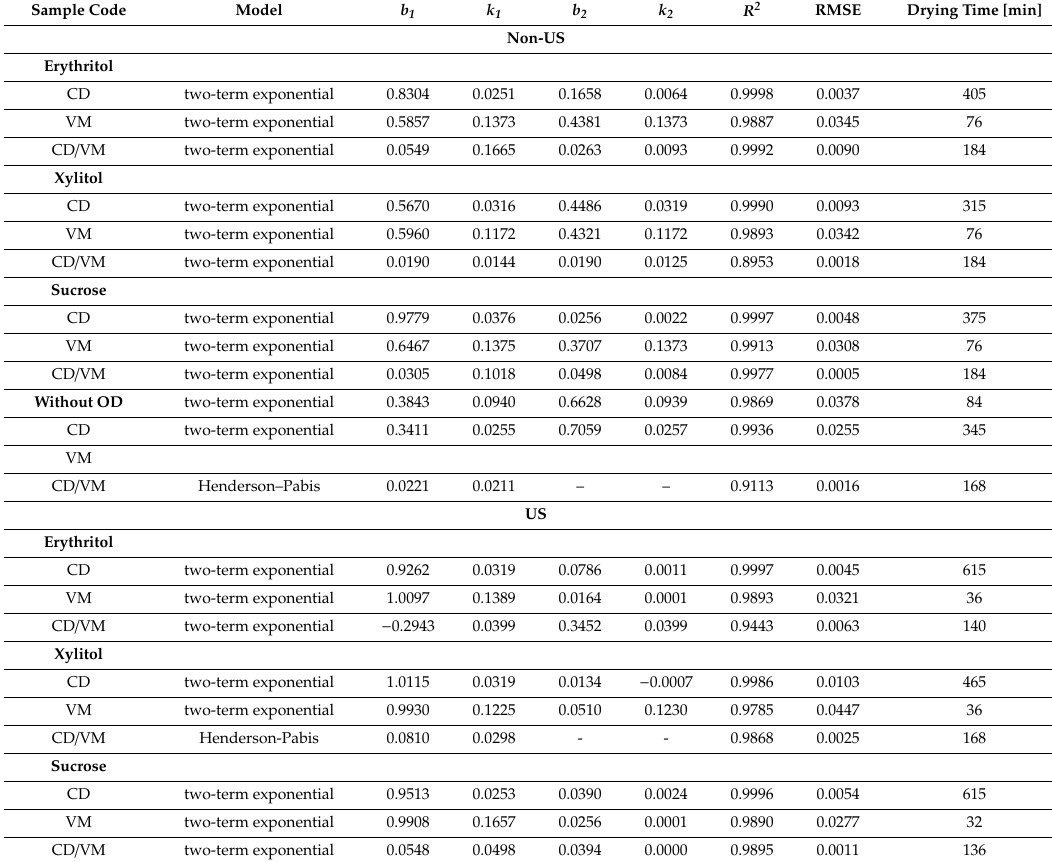
Table 1. Values of the parameters b 1 , k 1 , b 2 , k 2 , R 2 , and RMSE of the functions describe the drying kinetics, as well as total drying time of apple samples dried by di ff erent